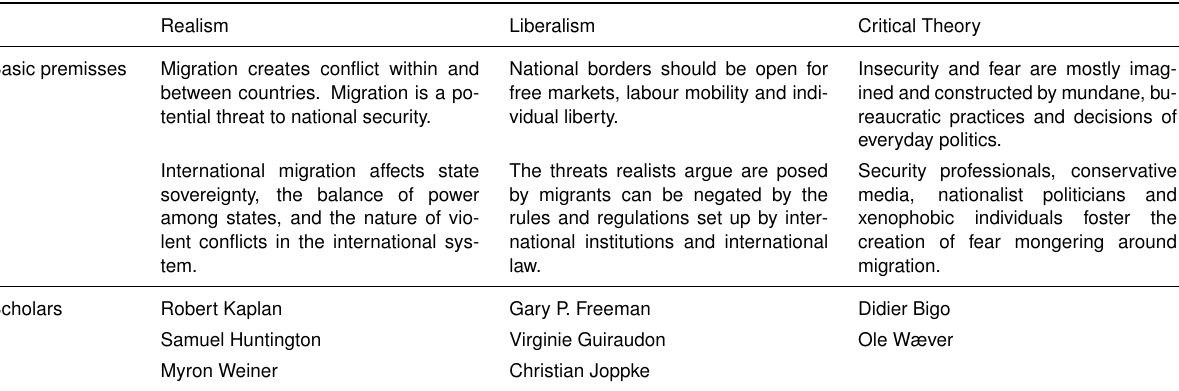
Table 1. Three models of securitisation of